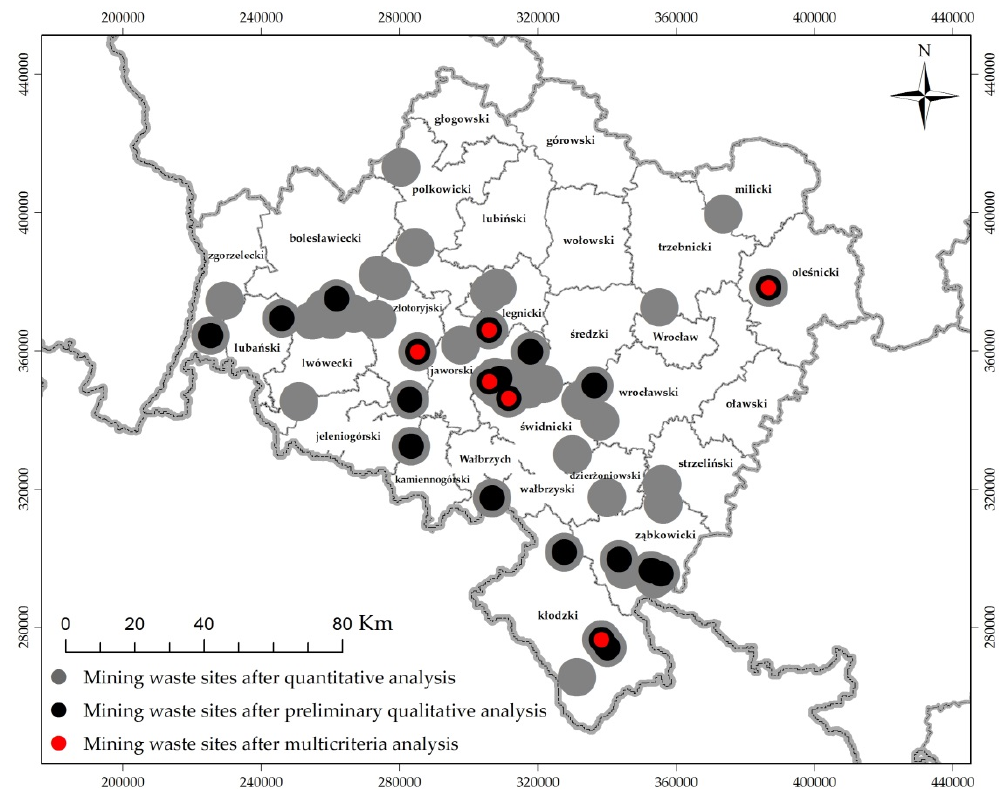
Figure A1. Location of waste treatment facilities.